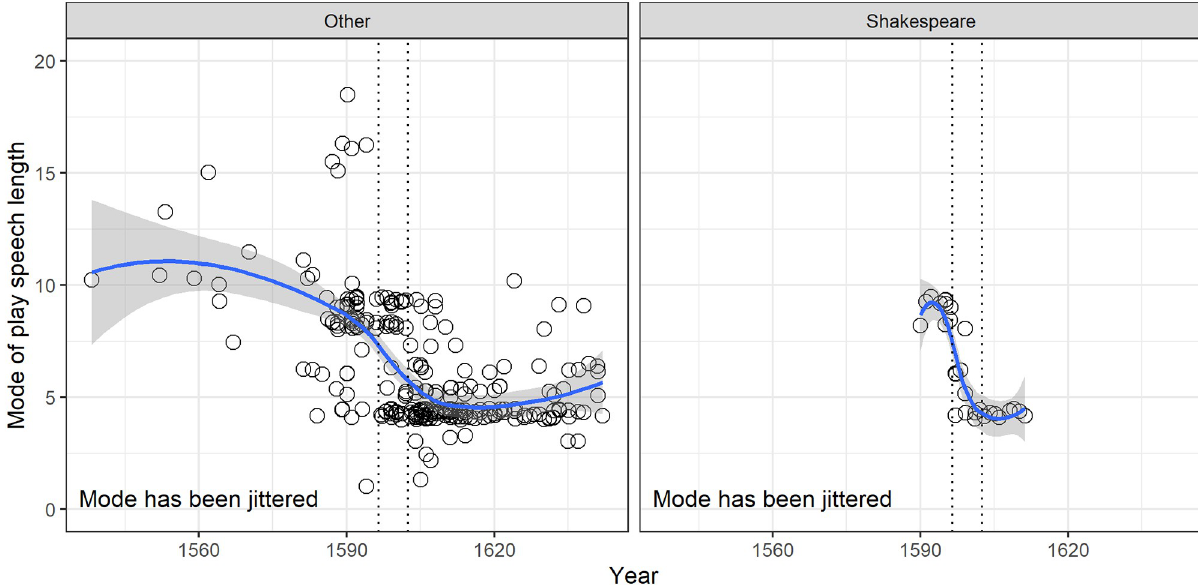
Fig 11. (S1 Fig 13 in S1 File) The modes for speech lengths for Shakespeare’s plays and for plays by others, with a lowess smoothed line, and the 95% confidence band. The range for Shakespeare plays is 1590 to 1613; the range for plays by other authors is 1538 to 1642. The 1597 and 1602 boundaries are shown as dotted vertical